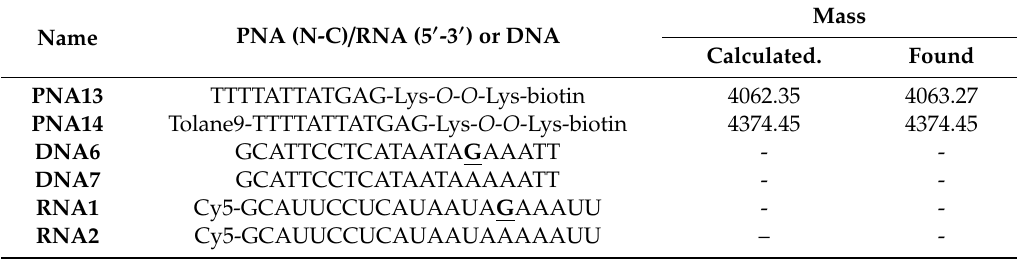
Table 6. PNA 13 and PNA 14 used to detect a neuraminidase inhibitor-resistant gene in influenza virus A / Yokohama / 77 / H1N1 derived from a single nucleotide polymorphism (SNP) within the sequence. RNA 1 contains the neuraminidase inhibitor-sensitive gene in influenza virus A / Yokohama / 1 / 2008 / H1N1, whileRNA 2 containstheneuraminidaseinhibitor-resistantgeneininfluenza virus A / Yokohama / 77 / 2008 / H1N1. DNA 6 and DNA 7 contain the same sequence as RNA 1 and RNA 2 , except that uracil bases were substituted with thymine bases.